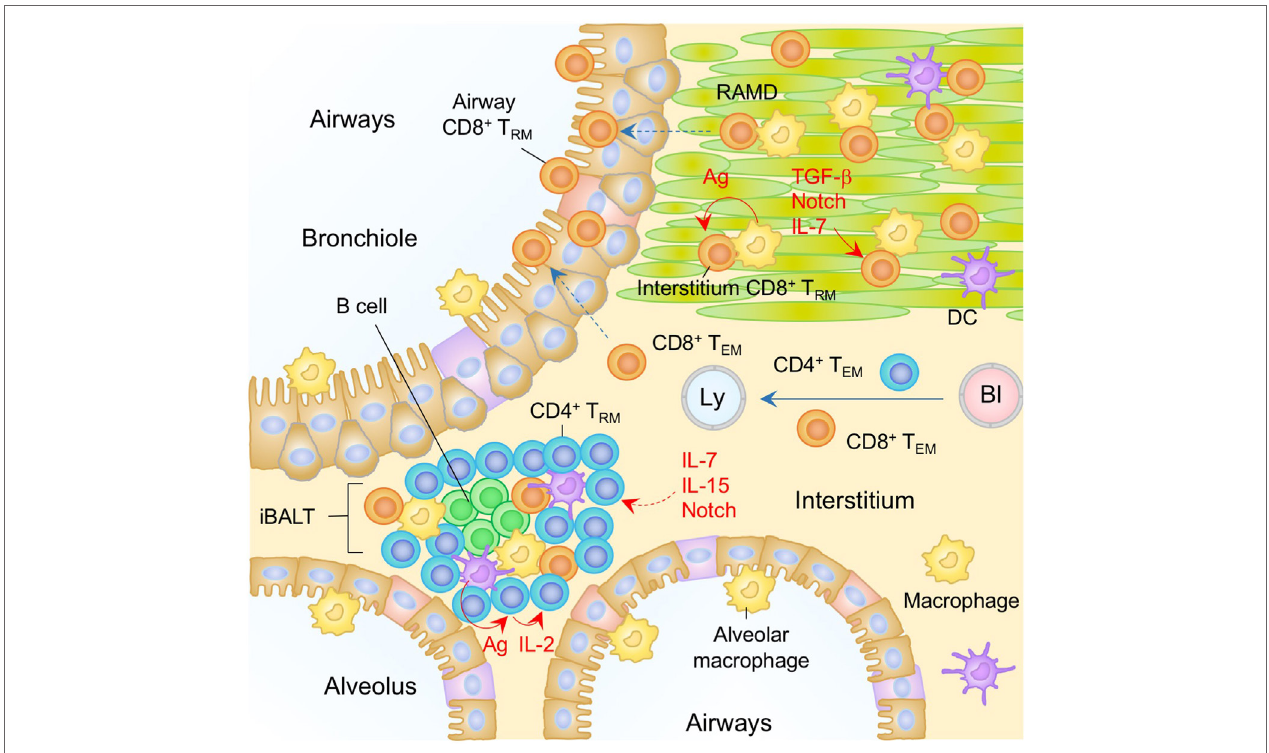
FiGURe 4 | T RM niches in the in the lung. A majority of CD8 + T RM cells in the lung interstitium are maintained within the repair-associated memory depots (RAMD) that are temporarily created at the site of tissue injury, while CD8 + T RM cells are found sparsely in the unaffected areas. A complex of niche factors, including signals via cognate antigen, TGF- β , Notch, and IL-7, are known to be involved in the formation of CD8 + T RM cells in the lung interstitium. CD8 + T RM cells are also present in the lung airways, the number of which is presumably maintained by continual recruitment of cells from the pool of CD8 + T RM cells in the lung interstitium. CD4 + T RM cells in the lung interstitium are maintained predominantly within the inducible bronchus-associated lymphoid tissues (iBALT). Late antigen recognition triggers autocrine IL-2 signaling, which supports the proliferation and survival of CD4 + T RM cells. Homeostatic cytokines IL-7 and IL-15, and Notch signaling are also required for the maintenance of CD4 + T RM cells in the iBALT. T EM cells are passing through the normal interstitium. Orange and blue cells indicate CD8 + and CD4 + T RM cells, respectively, unless otherwise stated. Red lines indicate the representative niche factors that influence the maintenance of T RM cells. A blue line indicates the migratory route. Dashed lines indicate potential impact of niche factors (red) or migratory routes (blue). Abbreviations: Ly, lymph vessel; Bl, blood vessel; Ag, antigen; T RM , tissue-resident memory T cells; T EM , effector memory T